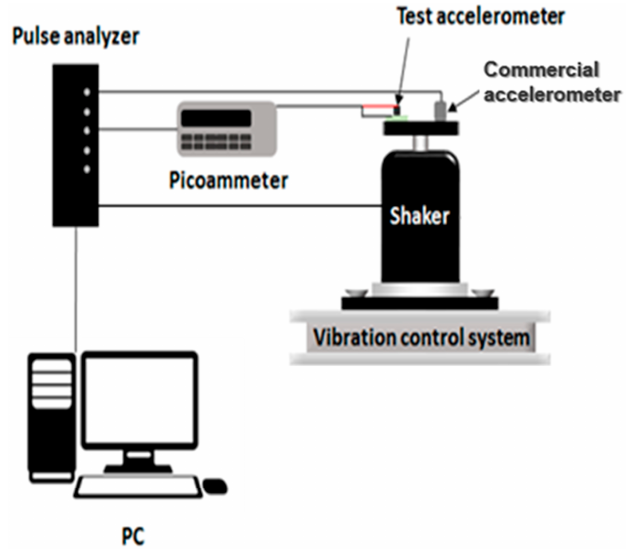
Figure 5. Schematic diagram of the experimental setup for the performance tests.